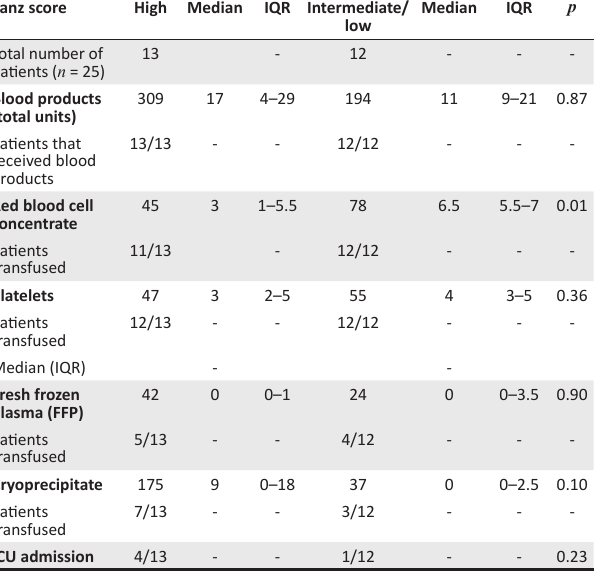
TABLE 5: Comparison of intensive care unit admissions and blood products received between the high-risk and non-high-risk groups based on the Sanz